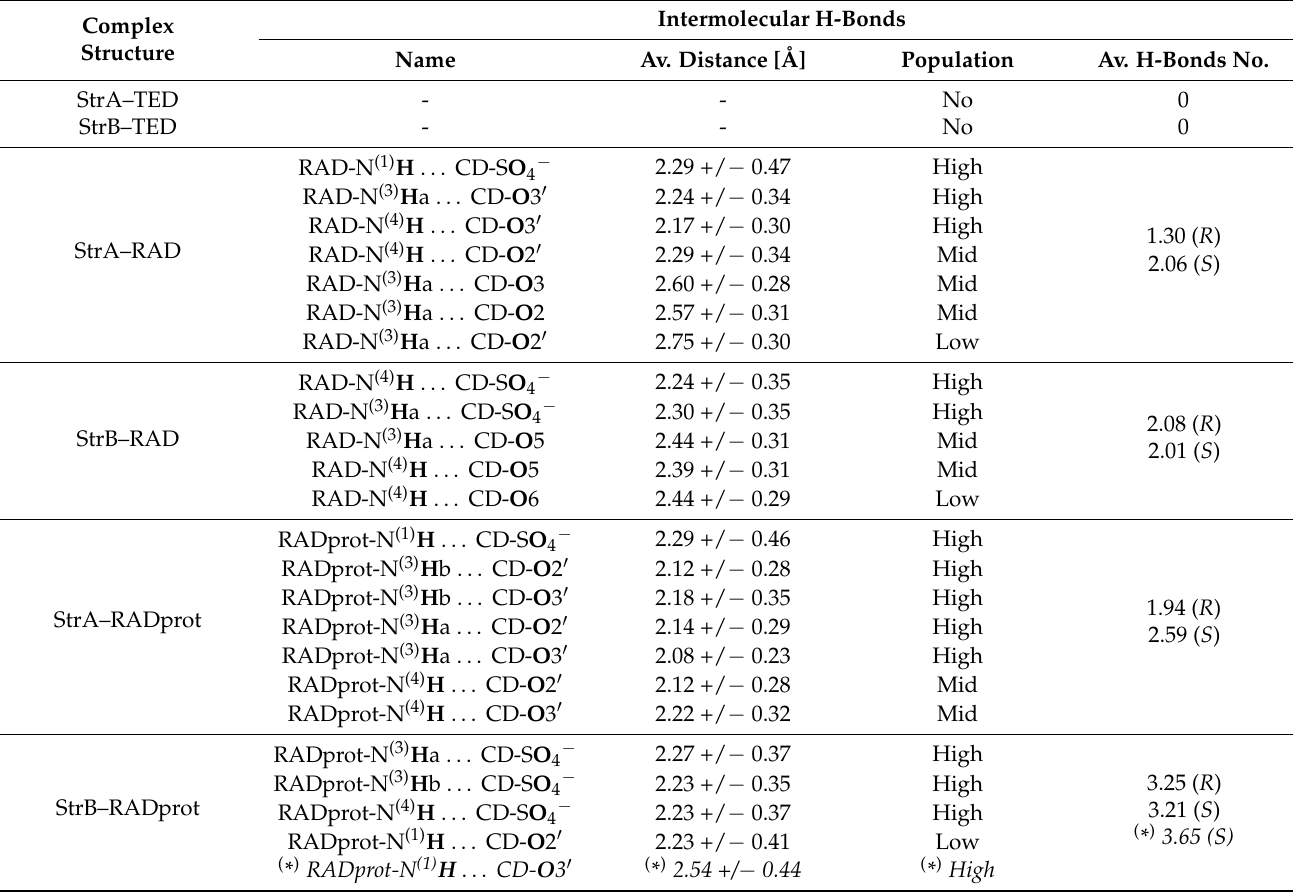
Table 3. Intermolecular hydrogen bonds (H-bonds) in oxazolidinone–HDAS- β -CD complexes. Complex